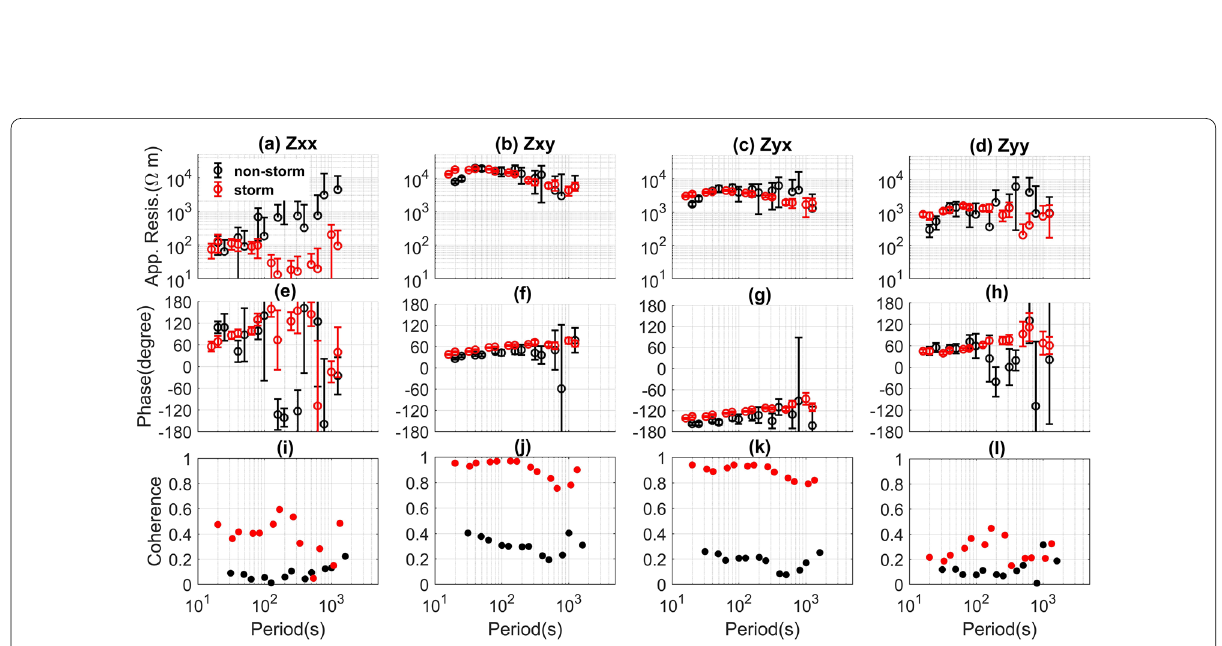
Fig. 8 MT sounding curves and coherence distributions during the storm and non-storm days using the data observed at site 142. The black color indicates the results calculated by the non-storm data observed from 00:00 on October 26 to 00:00 on October 29; the red color indicates the results calculated by storm data observed from 06:00 on October 29 to 06:00 on October